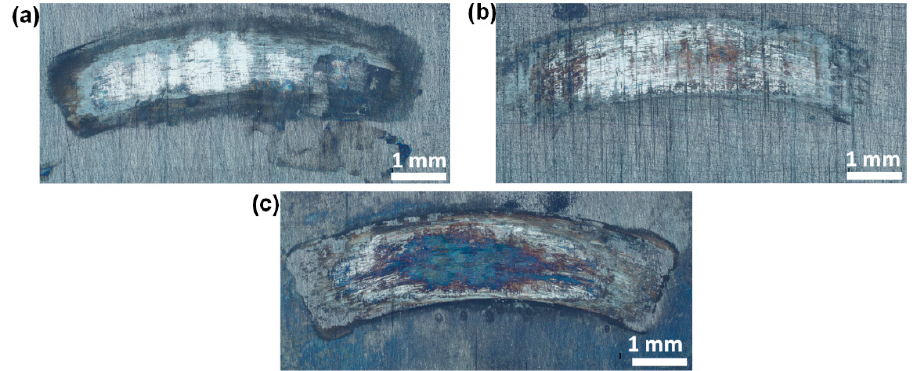
Figure 15. Optical morphologies of TiCN coating wear scars in artificial seawater: ( a ) 43 N; ( b ) 86 N; and ( c ) 106 N.